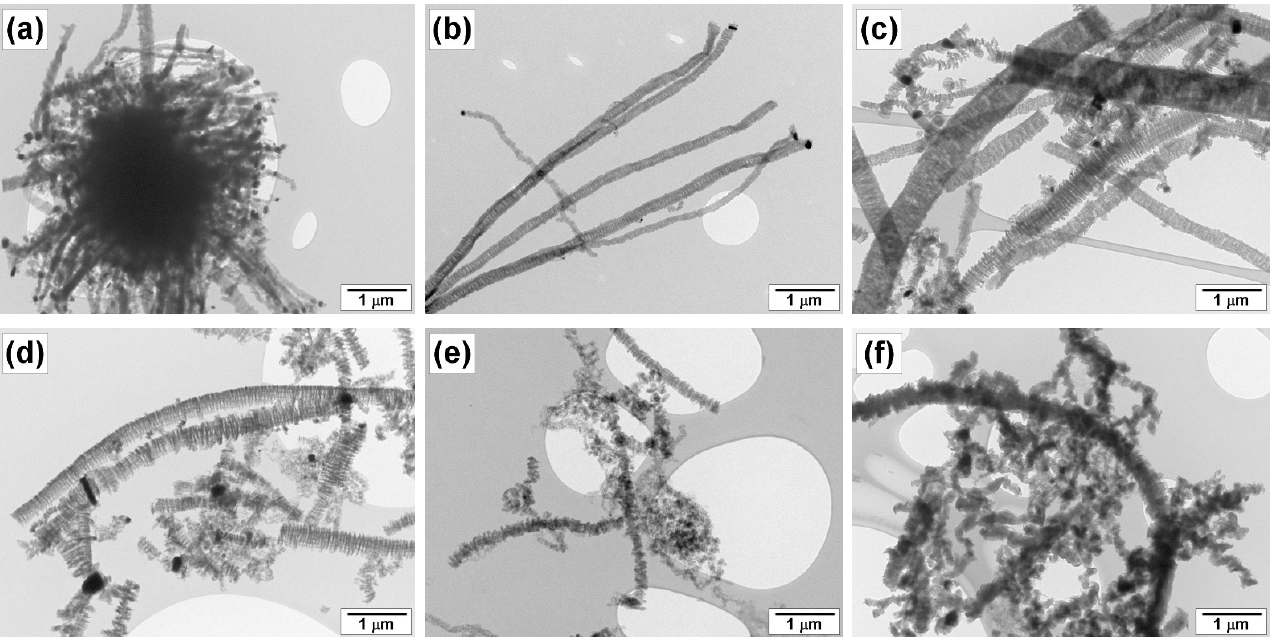
Figure 14. TEM images of the carbon product obtained via decomposition of TCE over 96Ni-4W alloy at temperatures: ( a ) 475 °C; ( b ) 500 °C; ( c ) 550 °C; ( d ) 600 °C; ( e ) 650 °C; ( f ) 700 °C.